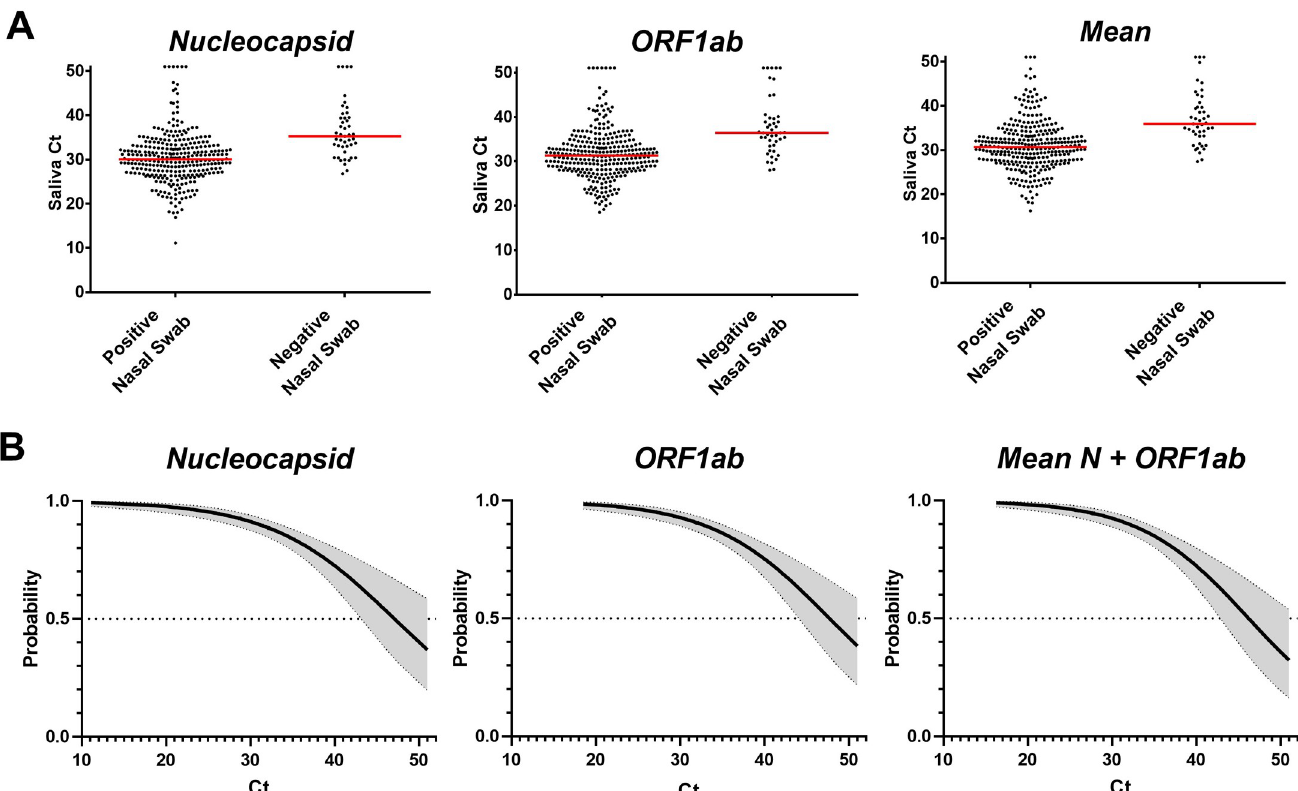
Fig 2. Association between saliva test Ct value and subsequent diagnosis of COVID-19. A) Ct values for two SARS-CoV-2 genes, ‘ N ’ and ‘ ORF1ab ,’ as well as their mean Ct and subsequent diagnostic result following re-test referral. Median saliva Ct values were significantly lower (p < 0.0001) for those testing positive by nasal swab. Each dot represents 1 participant sample. Genes which amplified within 50 cycles, but did not cross the threshold, were assigned a Ct value of 51 for post- hoc analysis. B) Probability of a subsequent positive diagnosis based on saliva Ct value was calculated using a logistic regression model. 95% confidence intervals are shown in gray on each side of the best fit